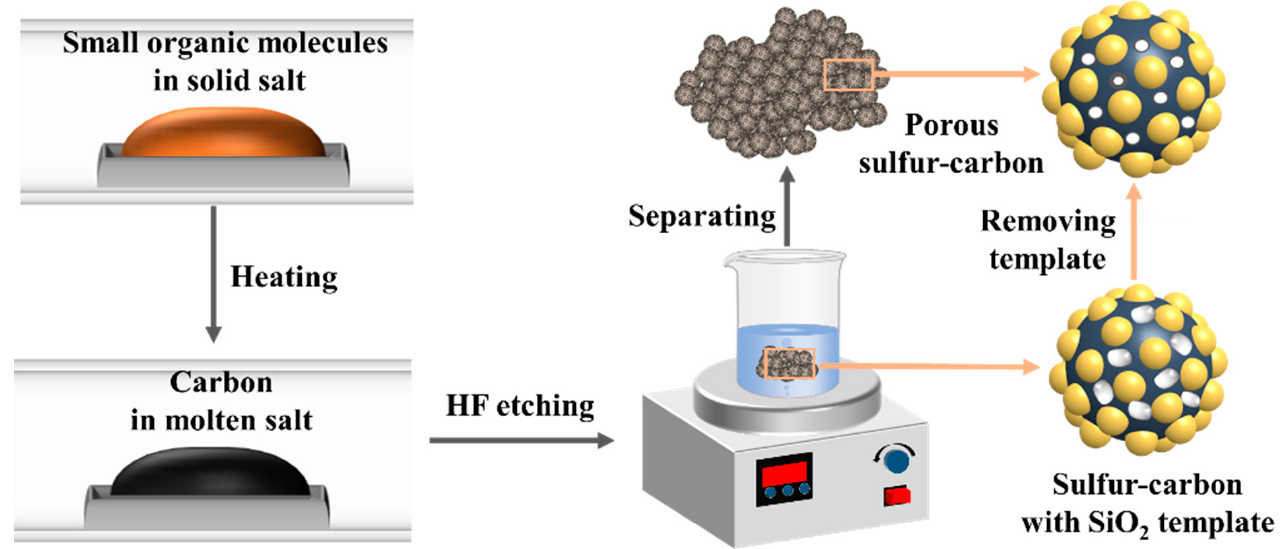
Figure 1. Schematic illustration of the synthesis process for S-C.